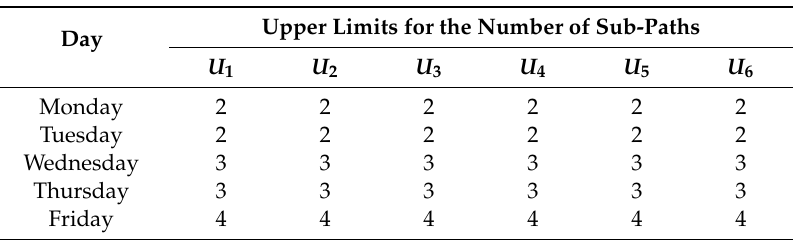
Table 10. Di ff erent upper limits for disposal facilities.